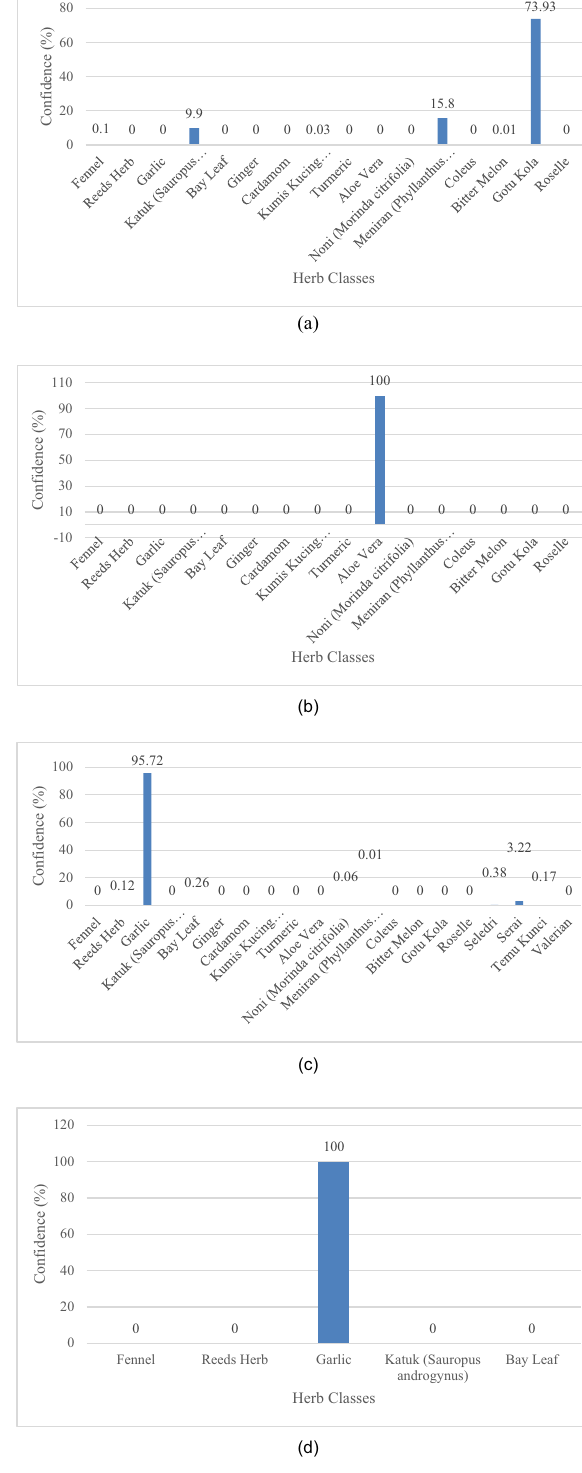
Figure 10: Graph of the percentage of the model's con fi dence in the analysis of images: ( a ) Pegagan leaves, ( b ) Aloe vera, and ( c and d )